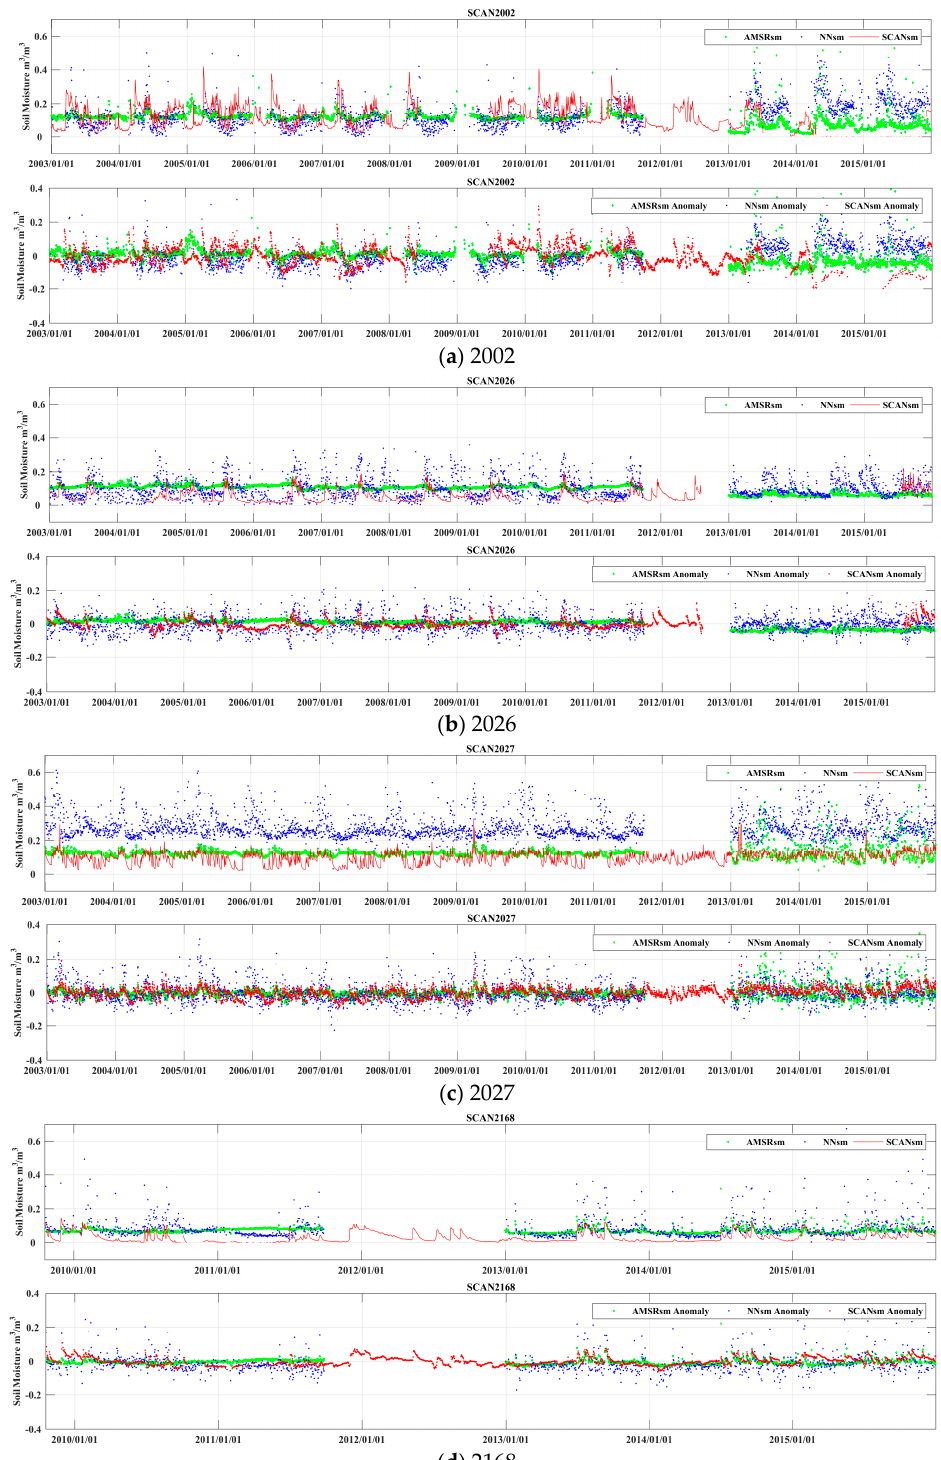
Figure 9. Time series (upper panel) and anomaly time series (lower panel) for SCANsm (red line), NNsm (blue dots) and AMSRsm (green diamonds) over the long time period (2003–2015) in sites: ( a ) 2002; ( b ) 2026; ( c ) 2027; and ( d ) 2168.